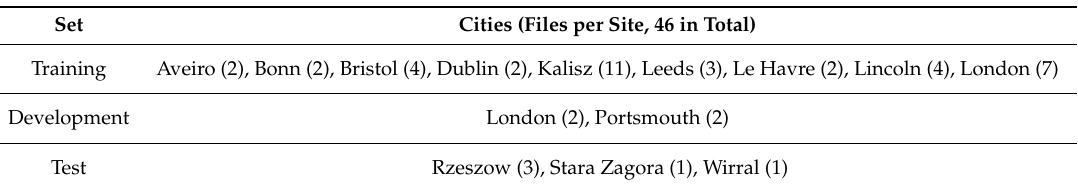
Table 2. Image distribution in data